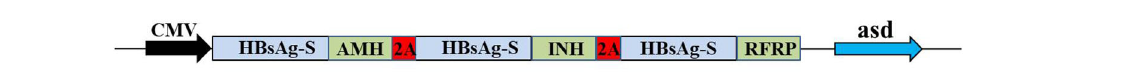
FIGURE 1 Schematic map for the construction of AMH-INH-RFRP DNA